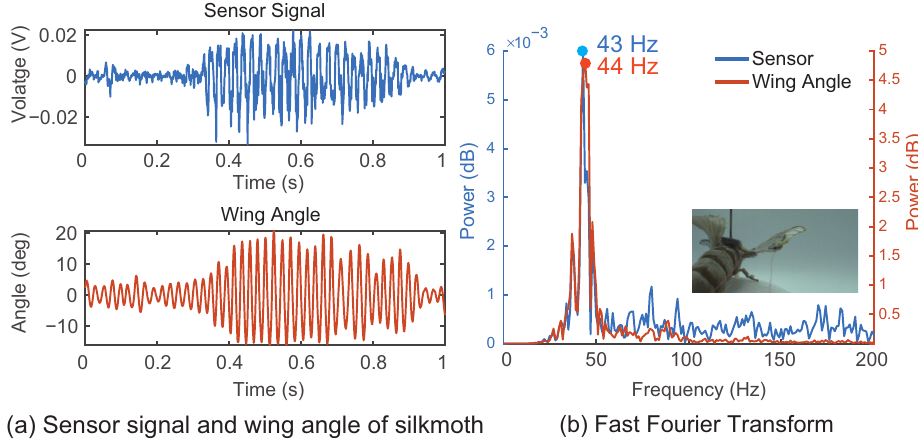
Figure 7. Sensor signal and wingbeat of a tethered silk moth. The results for the measured sensor signal and the corresponding wing angle are shown in ( a ). FFT and peak values are shown in ( b ). A comparison between the measured sensor signal with the wingbeat derived